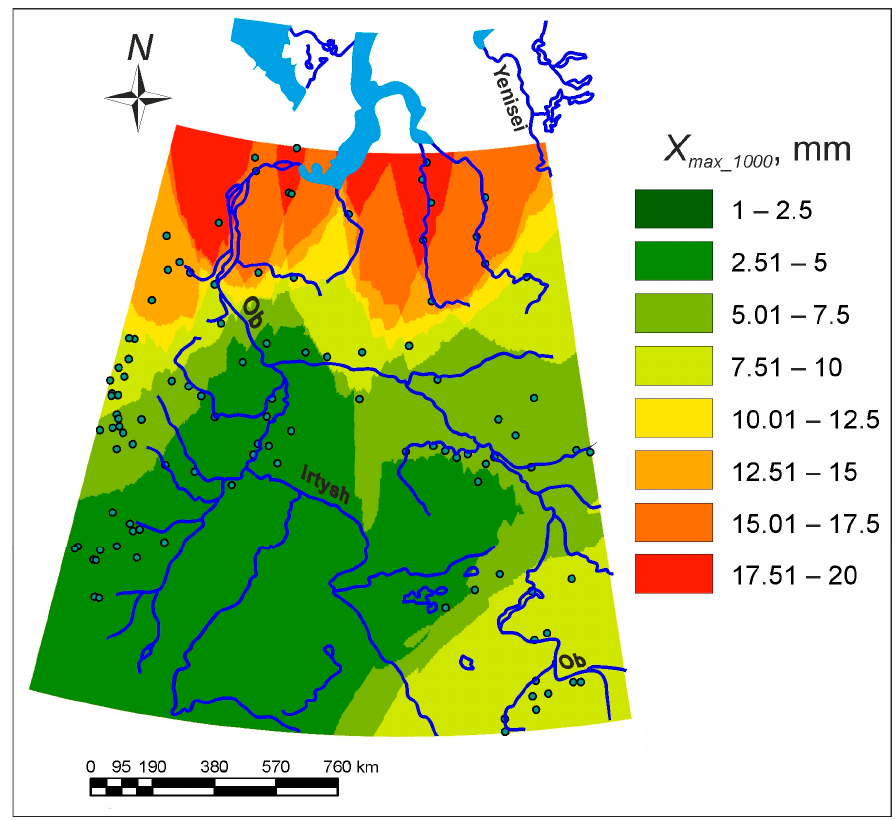
Figure 11. Distribution of the modern effective maximum daily surface runoff depth X max _1000 for a unit basin.